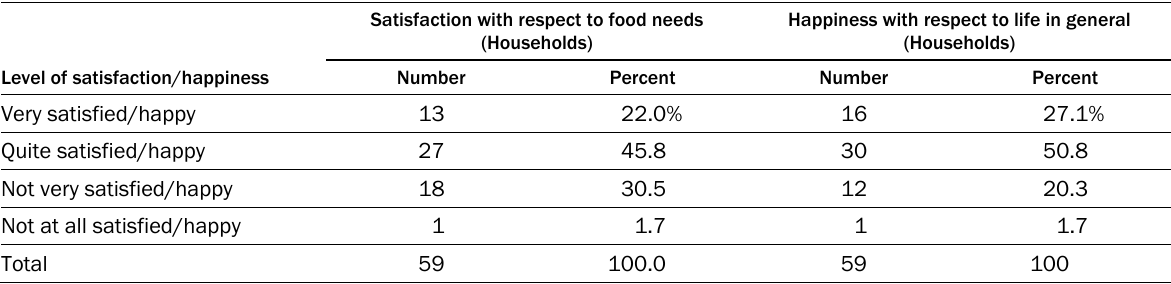
Table 5. Levels of Food Needs Satisfaction and Overall Happiness